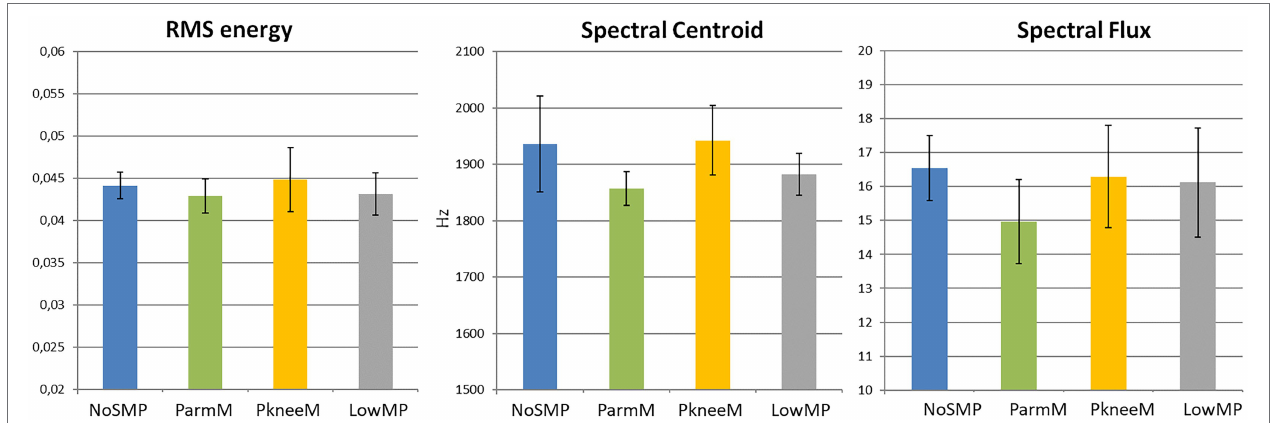
FIGURE 5 | Mean values of the acoustic parameters by motion type (Abbreviations of the motion types see Figure 1 ; error bar: standard error of the